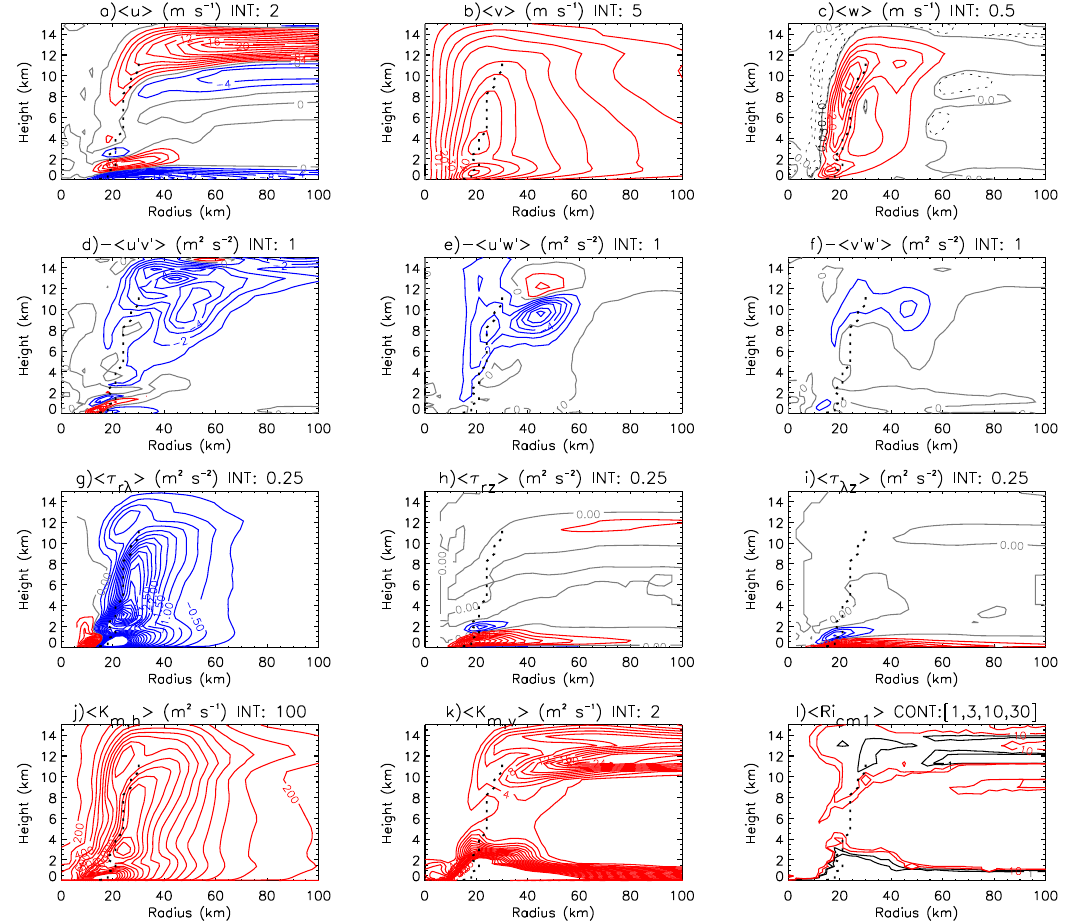
Fig. 17. Radius-height contour plots of resolved and subgrid eddy momentum fluxes and related quantities from the 3D3k simulation using data at a 10-minute interval and averaged over a mature period (214 - 226 h). Except where otherwise noted, there are 20 positive red contours and 20 negative blue contours. Panel (a): h u i with contour interval 2 m s − 1 ; panel (b): h v i with contour interval 5 m s − 1 ; panel (c): h w i with contour interval 0.5 m s − 1 ; panel (d): resolved horizontal momentum flux h− u ′ v ′ i with contour interval 1 m 2 s − 2 ; panel (e): resolved vertical eddy flux of radial momentum h− u ′ w ′ i with contour interval 1 m 2 s − 2 ; panel (f): resolved vertical eddy flux of tangential momentum h− v ′ w ′ i with contour interval 1 m 2 s − 2 ; panel (g): subgrid momentum flux corresponding to panel (d) h τ rλ i with contour interval 0.25 m 2 s − 2 ; panel (h): subgrid momentum flux corresponding to panel (e) h τ rz i with contour interval 10 × 10 − 3 m 2 s − 2 ; panel (i): subgrid momentum flux corresponding to panel (f) h τ λz i with contour interval 10 × 10 − 3 m 2 s − 2 ; panel (j): horizontal diffusivity h K m,h i with contour interval 200 m 2 s − 1 ; panel (k): vertical diffusivity h K m,v i with contour interval 2 m 2 s − 1 ; panel (l): time and azimuthal average of the gradient Richardson number used in the CM1 model h Ri cm1 i with black contours 1 and 3 and red contours 10 and 30. The radius of maximum h v i at each height is shown with the black dashed curve (up to 11 km).